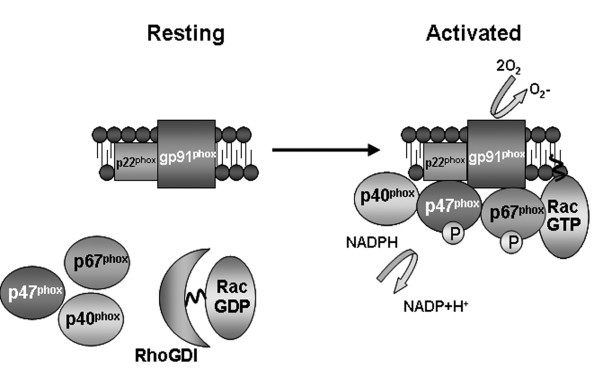
Activation of the phagocytic NADPH oxidase complex. Stimulation of the phagocyte induces the parallel activation of oxidase components within the cytoplasm. This activation causes the conversion of Rac into an active GTP-bound form and the phosphorylation of p47phox and p67phox. These subunits then translocate to the membrane where they interact with p22phox and gp91phox (NOX2) to initiate reactive oxygen production.